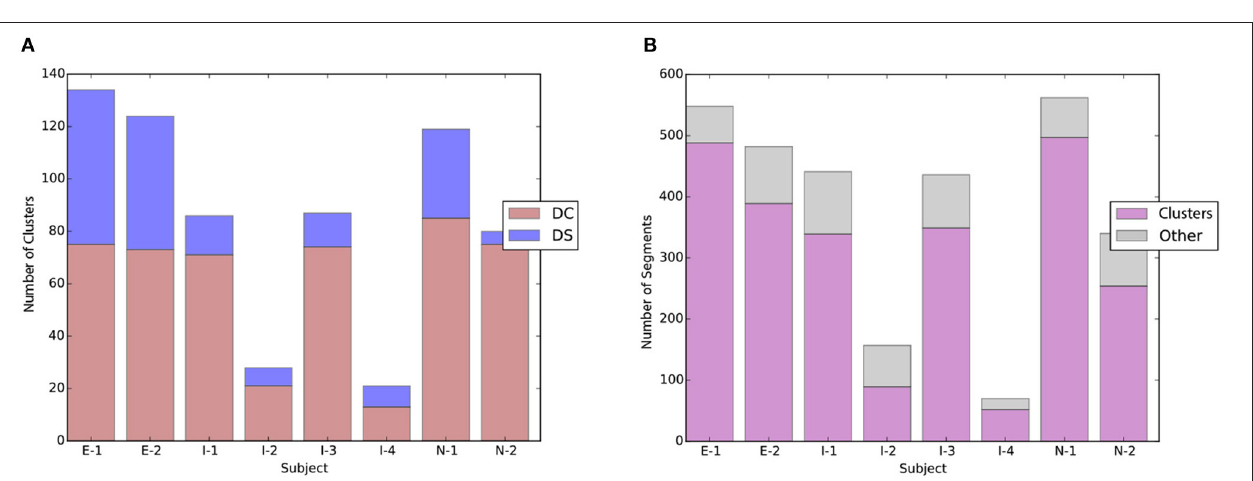
FIGURE 14 | (A) Distribution of Drill-Correct vs. Drill-Smooth clusters in the experimental data; (B) distribution of DC/DS clusters vs. other practice patterns. (A) Ratio of Drill-Correct vs. Drill- Smooth clusters. (B) Ratio of DC/DS vs. other patterns.